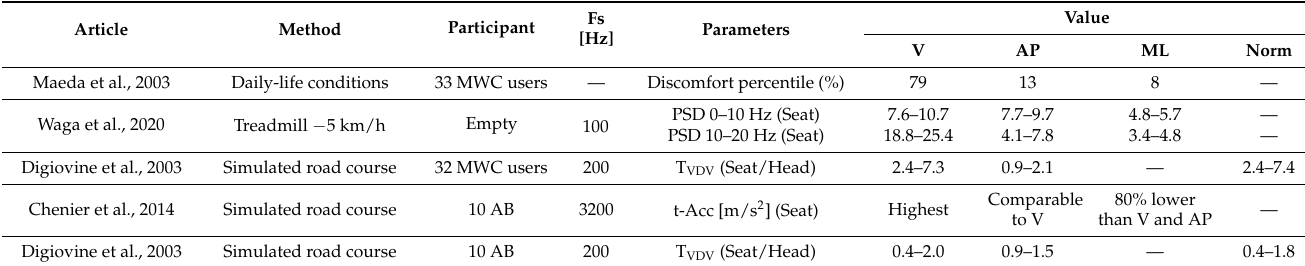
Table 2. Summary table of the reviewed studies regarding vibration direction: Vertical (V), anteroposterior (AP) and mediolateral (ML)